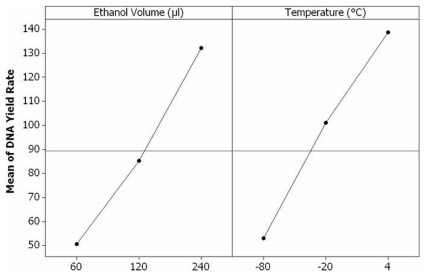
Main effects plot of ethanol volume and temperature on DNA yield rate resulted from precipitation.The horizontal reference line is drawn at the overall mean of DNA yield rate. The dots display the response means for each factor level. The effects are the differences between the means and the reference line.